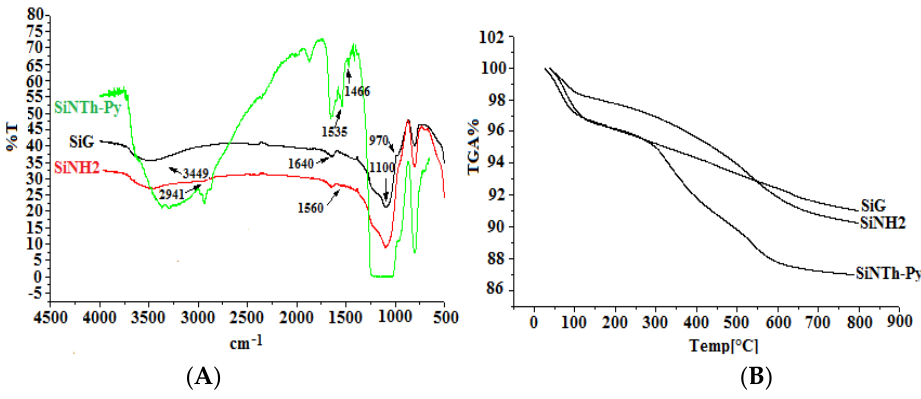
Figure 3. ( A ) FT-IR Spectra; ( B ) Thermogravimetric curves of free silica SiG, SiNH 2 and SiNTh-Py.